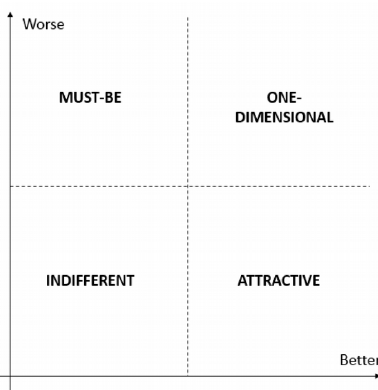
Figure 9. Characteristic areas of quality attributes according to the low or high values of the Better / Worse indexes